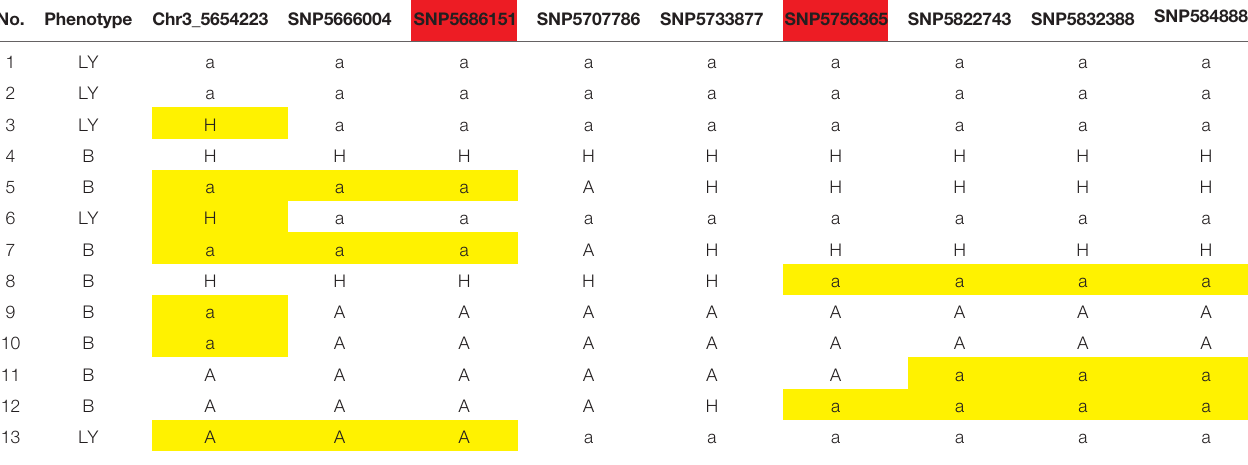
TABLE 1 | Phenotypes and genotypes of recombinant individuals showing the recombinant breaking points.